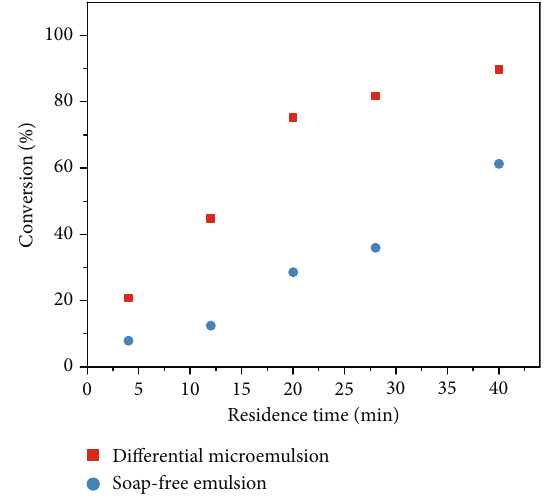
Figure 10: Conversion versus residence time pro fi les for di ff erential microemulsion polymerization and soap-free emulsion polymerization ( W : O = 1 : 5 : 1 , t 1 = 20 min, T = 80 ° C, the concentration of APS was 5mM, and the solid content of the initial microemulsion was 5.0wt.%).